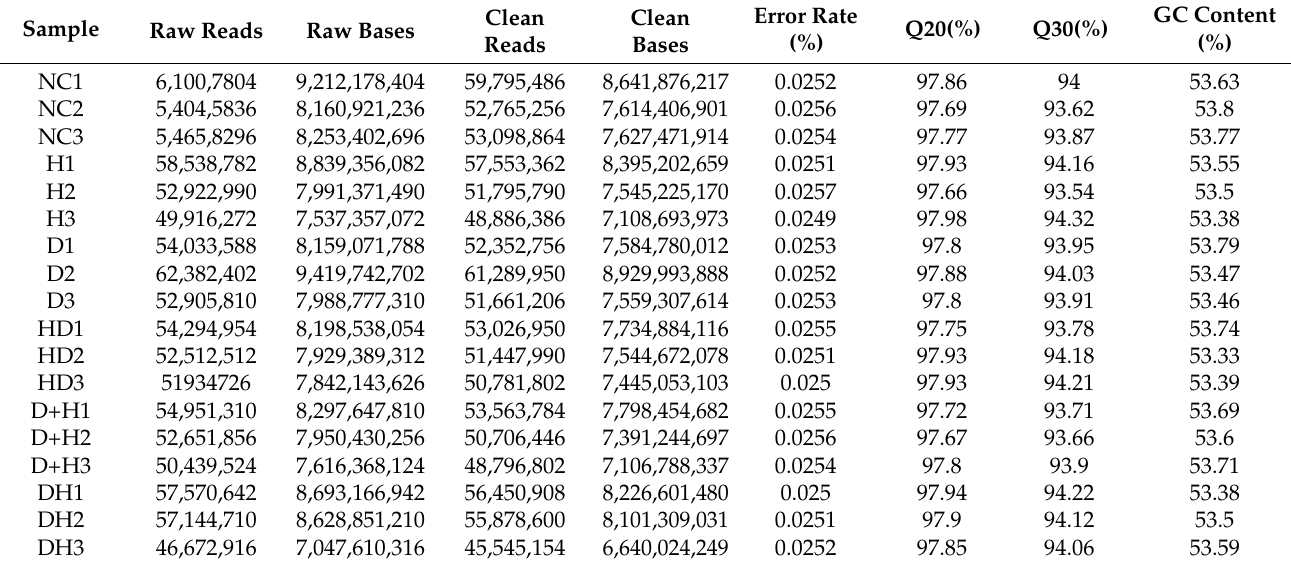
Table A1. Information of RNA-seq samples.